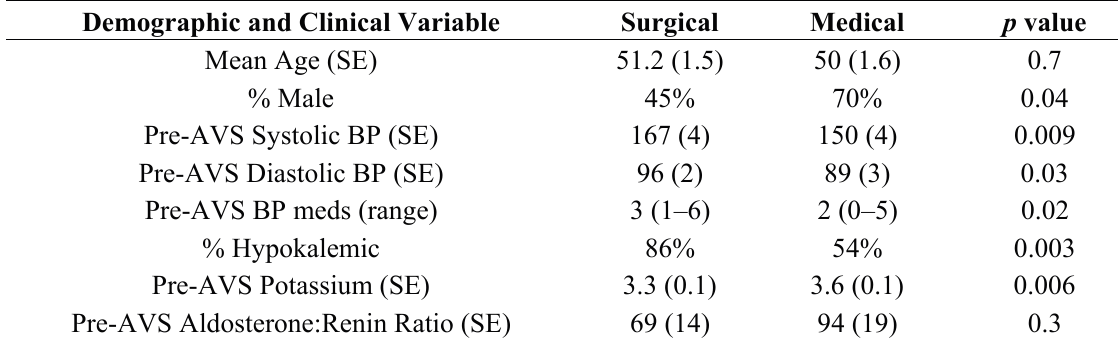
Table 1. Pre-AVS demographic and clinical data. Patients who eventually underwent surgery had significantly higher initial blood pressure (mmHg) and were more likely to be